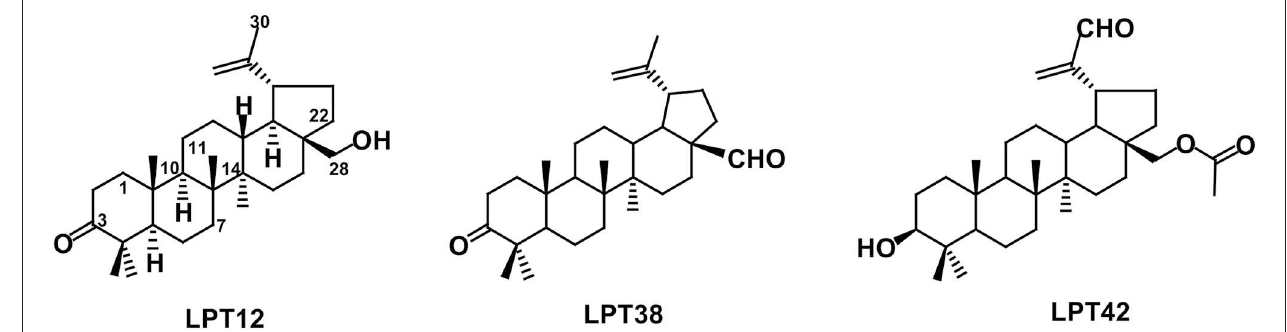
FIGURE 1 | Chemical structures of LPT12, LPT38 and